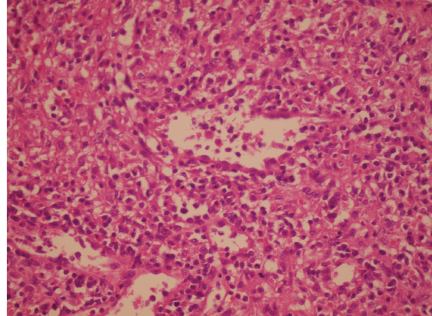
Figure 1: Splenic section H&E; red pulps expanded by heavy infiltration of plasma cells and histiocytes. No Leishman body is